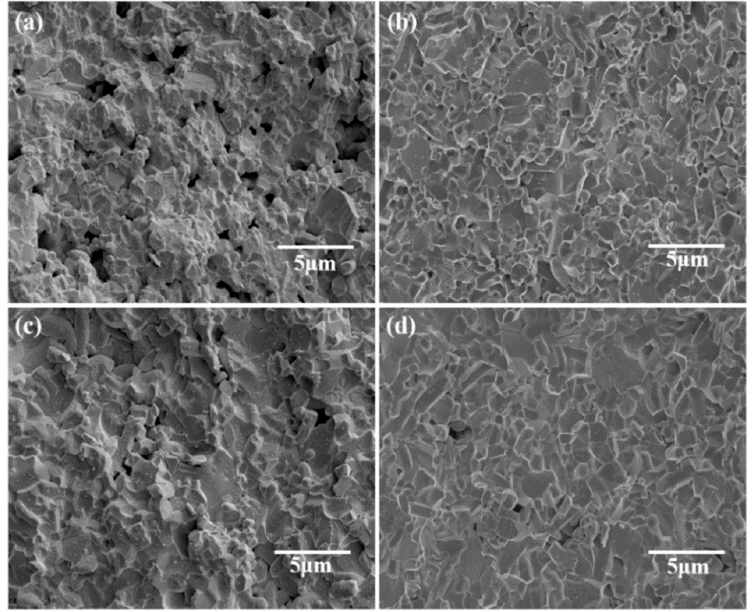
Figure 4. SEM micrographs of the cross-sections of the MLLC9.5 ceramics sintered at different temperatures. ( a ) 775 °C, ( b ) 800 °C, ( c ) 825 °C, and ( d ) 850 °C.